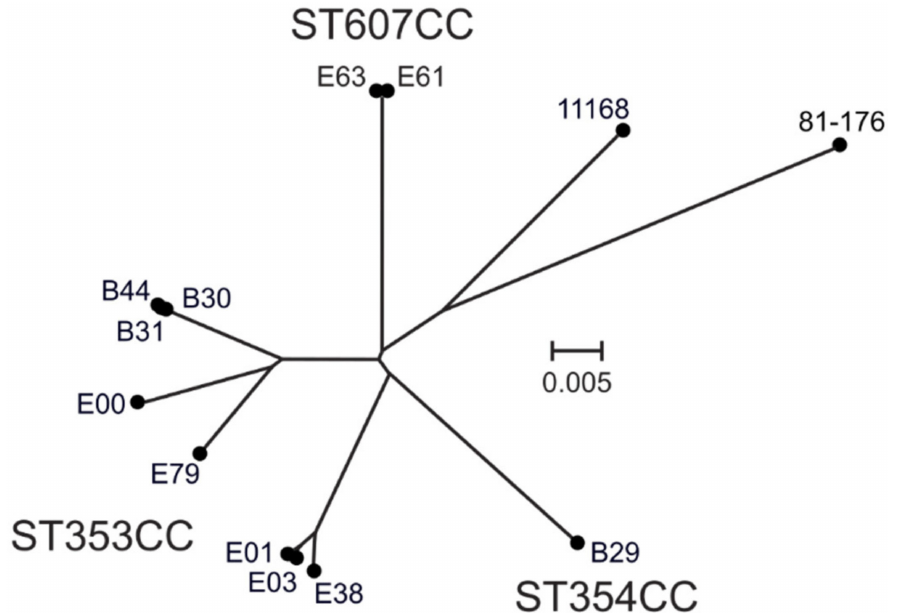
Figure 1. ANI-based whole-genome sequence phylogenetic tree of the eleven isolates sequenced in this study, together with the C. jejuni 11168 and 81-176 reference strains, showing the separation of ST353CC, ST354CC, and